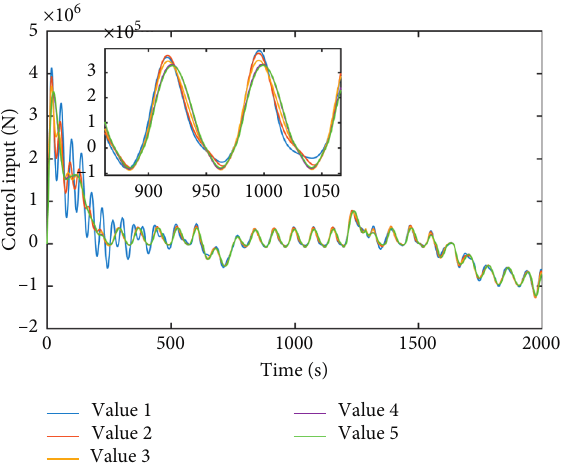
Figure 7: Control input.